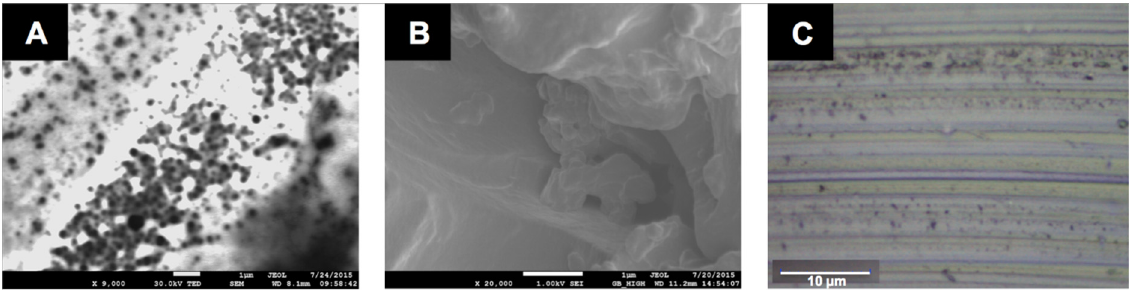
Figure 4. Settling tests comparing suspensions of carbon nanotubes (CNTs) in tung oil, dimethyl sulfoxide (DMSO), and the crude monomer mixture comprised of 1.4 g of tung oil, 0.2 g of divinylbenzene, and 0.3 g of styrene. ( a ) CNTs in DMSO after resting for 5 min; ( b ) CNTs in tung oil after resting for 5 min; ( c ) CNTs in the crude monomer mixture after resting for 5 min; ( d ) CNTs in DMSO after resting for 60 min; ( e ) CNTs in tung oil after resting for 60 min; and ( f ) CNTs in the crude monomer mixture after resting for 60 min.